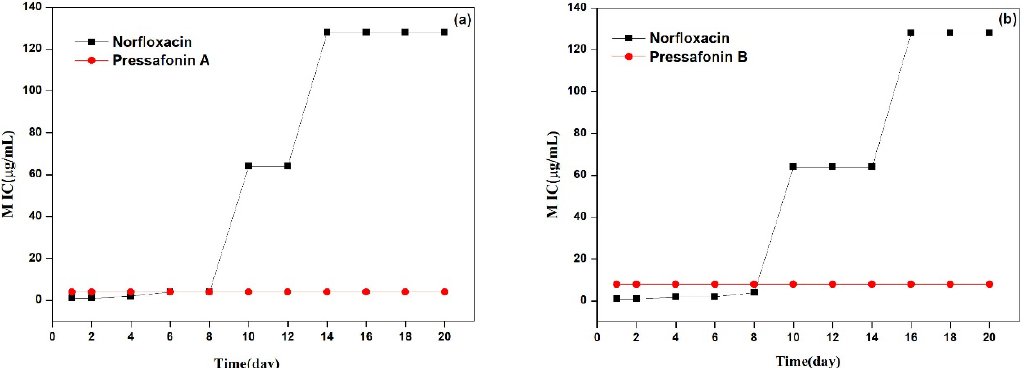
Figure 4. Bacterial resistance study of compounds 6 ( a ) and 7 ( b ) against S. aureus ATCC 29213 in the presence of 1/2× MIC levels. Norfloxacin (MIC = 2 μg/mL) was selected as a positive.